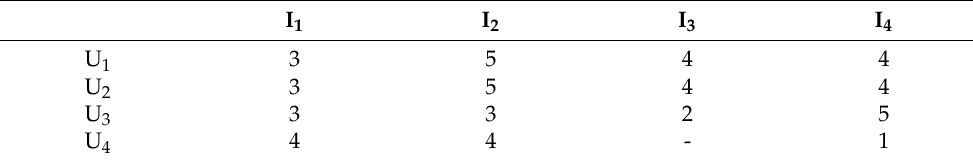
Table 7. Corrected Ratings for the Given Example.